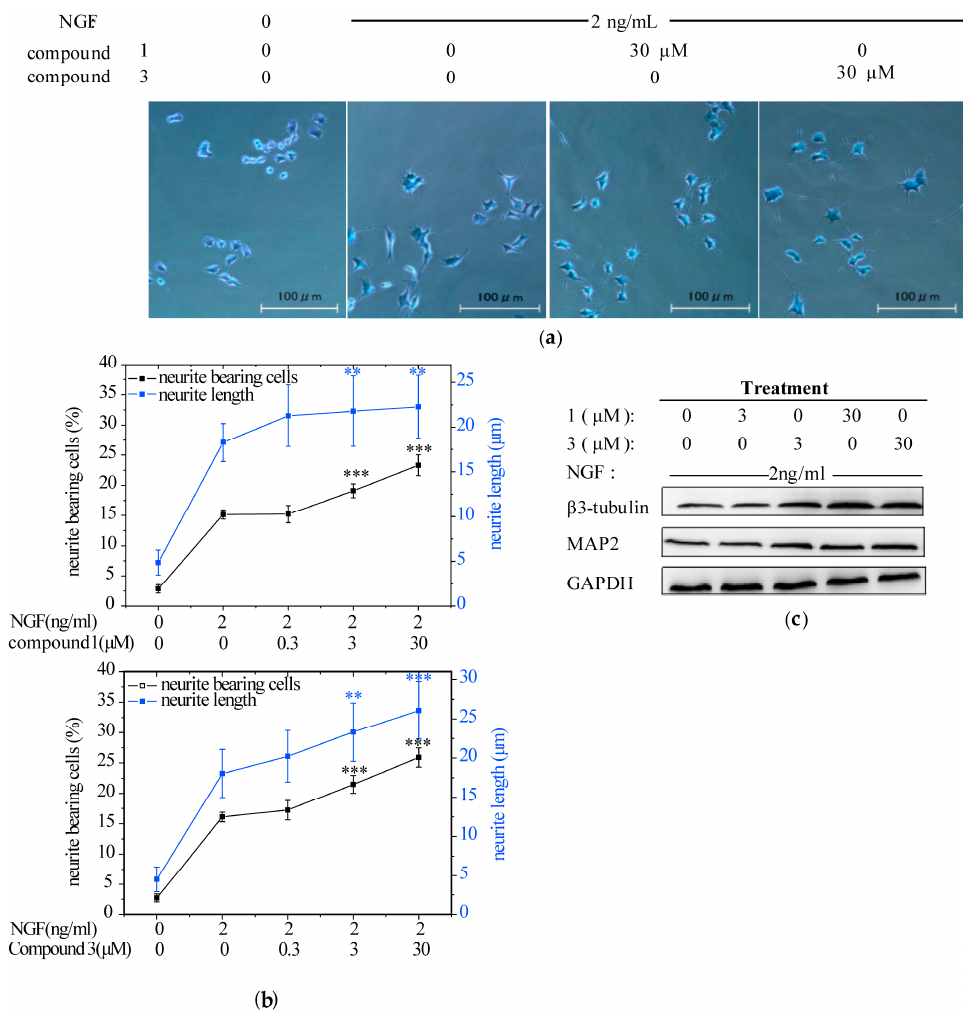
Figure 3. The effect of compounds 1 and 3 from the mycelium of H. erinaceus on promoting nerve growth factor (NGF)-induced neurite outgrowth in PC12 cells. PC12 cells were seeded in collagen-coated 24-well plates in normal serum medium for 24 h, then changed to a low-serum medium (2% HS and 1% FBS) and exposure to vehicle (0.1% DMSO) as a negative control, NGF (2 ng/mL) as a positive control, or NGF (2 ng/mL)+1 or 3 (0.3, 3, 30 μ M) for additional 96h. Scale bar: 100 μ m. ( a ) Cell morphology was observed and photographed as described in the analysis of neurite outgrowth; ( b ) Neurite bearing cells and neurite length were measured as described in the analysis of neurite outgrowth. Data are expressed as the mean ± SD from three independent experiments. ** p < 0.01, *** p < 0.001 represent significant differences compared with NGF-treated PC12 cells (positive control) (Analysis of variance (ANOVA) followed by Dunnett’s test); ( c ) Western blotting analysis of the protein expression of neuronal differentiation markers: β 3-tubulin and MAP2 (microtubule associated protein 2). Glyceraldehyde-3-phosphate dehydrogenase (GAPDH) was detected as the control of protein loading.